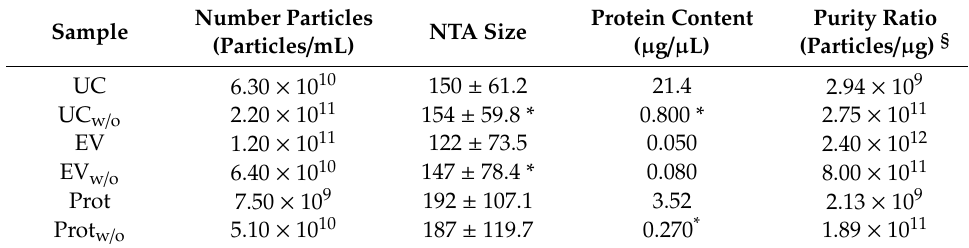
Table 2. Particles characterization in terms of quantity, size and